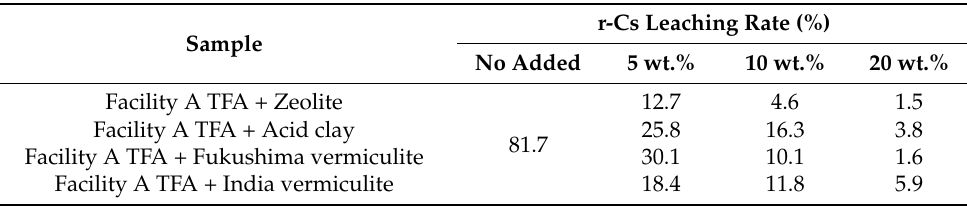
Table 8. Changes in radioactive cesium (r-Cs) leaching rate according to wt.% of clay minerals (chelate-treated fly ash, TFA).